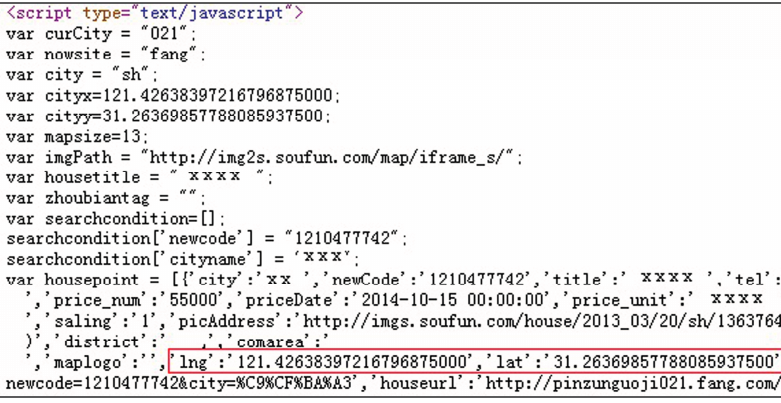
Figure 1. Example JavaScript codes with a built-up area from the SouFun